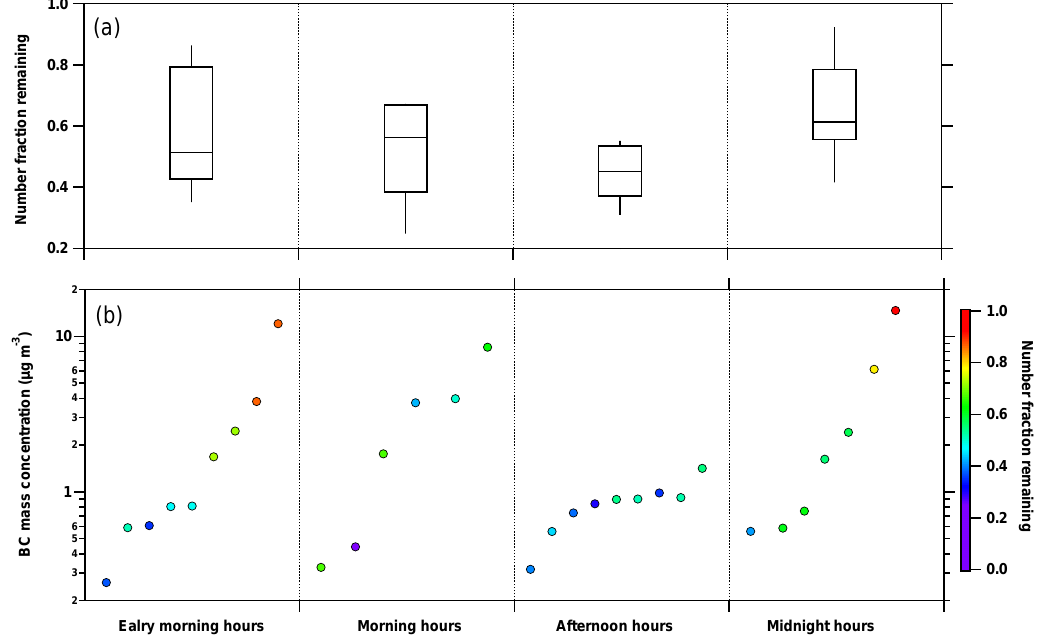
Figure 4. (a) Box-and-whisker plot showing median and 25th and 75th percentile levels for NFR during the Athens 2013 campaign when the TD was set at 400 ◦ C for the different periods of the day. Vertical lines represent range from 0 to 100%. (b) BC mass concentration measured with MAAP. The color scale represents number fraction remaining. The different periods of the day were early morning